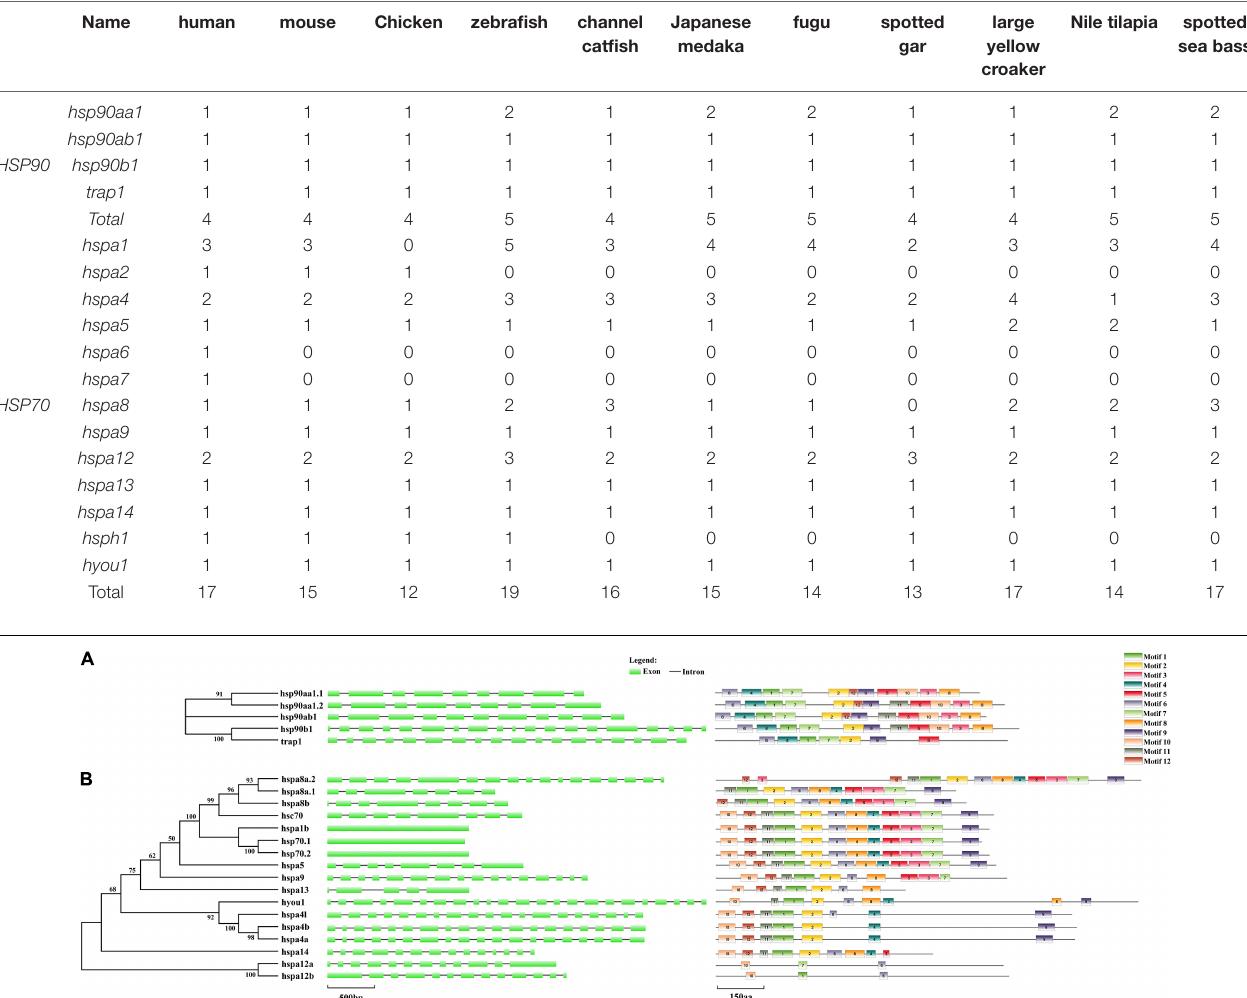
TABLE 3 | Copy numbers of HSP90 and HSP70 genes among several representative vertebrate species.